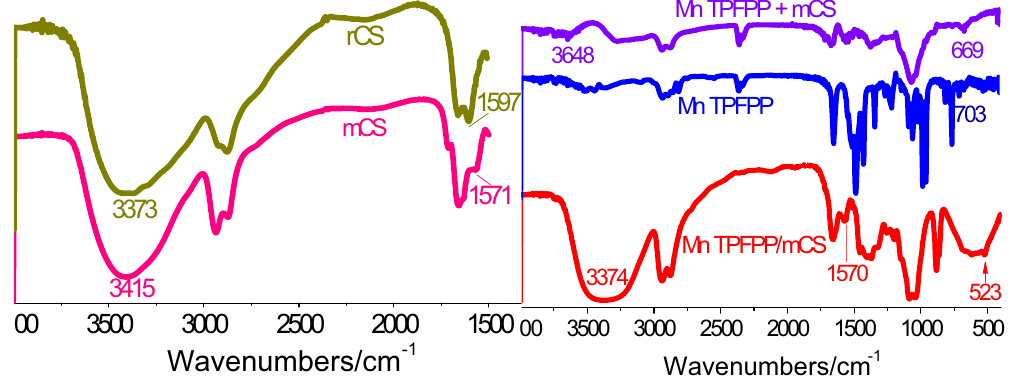
Figure 3. FT-IR spectra of rCS, mCS, Mn TPFPP, mCS + Mn TPFPP, and Mn